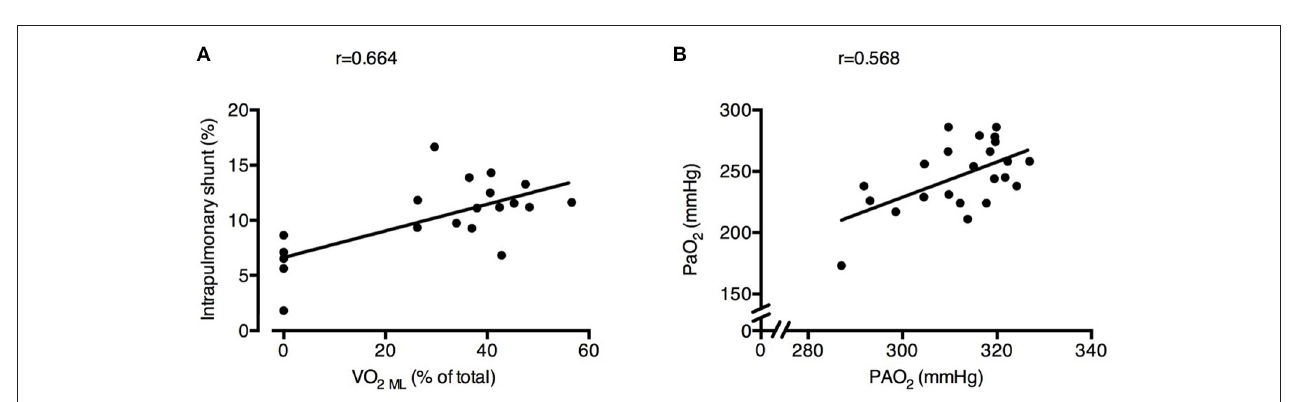
FIGURE 5 | Physiological changes induced by decreased respiratory rate and increased extracorporeal CO 2 removal associated with increased intrapulmonary shunt and poorer arterial oxygenation. Higher oxygen transfer by the ECMO membrane lung (VO 2 ML) was correlated with larger intrapulmonary shunt fraction (A) . Alveolar O 2 pressure (PAO 2 ) was correlated with systemic arterial partial pressure of O 2 ( PaO 2 ) (B) . See text for methodological details. Number of observations were n = 20 in (A) due to impossibility of blood withdrawal to calculate VO 2 ML in one of the animals and n = 23 in (B) due to blood gas analyzer failure for one arterial